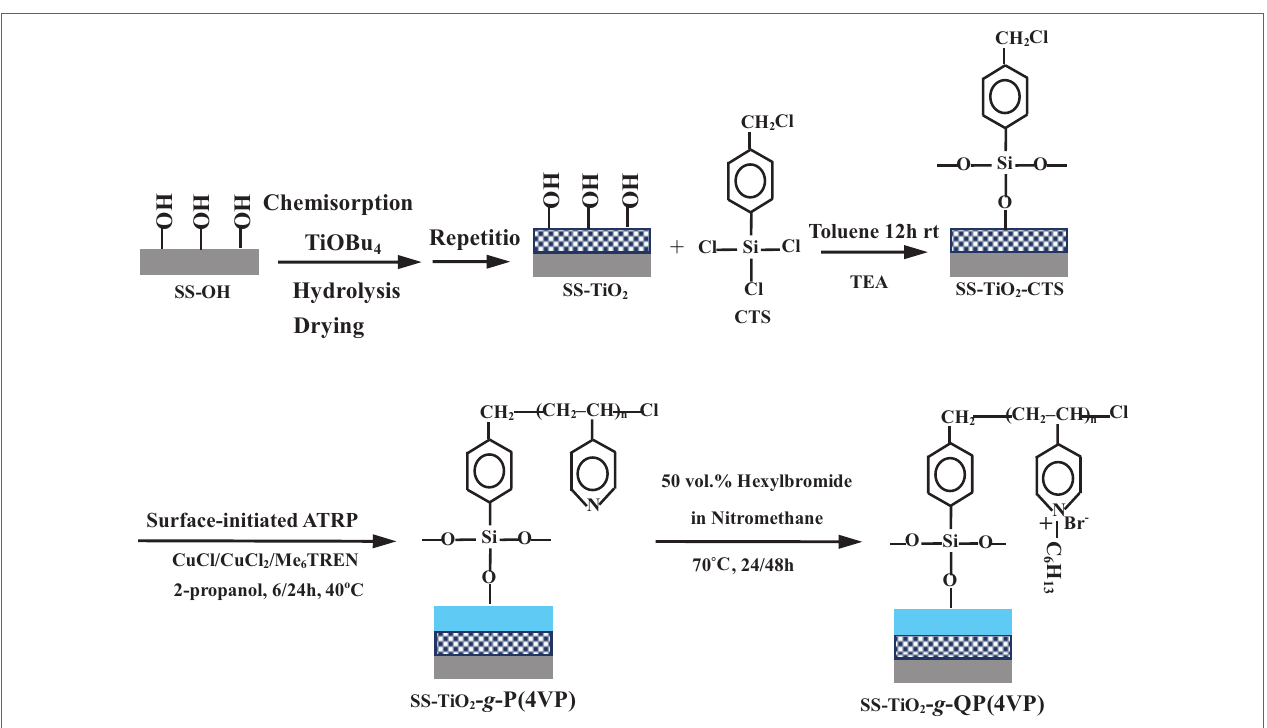
FiGURe 6 | Process in preparing organic/inorganichybrid coatings via combination of layer-by-layer sol-gel deposition and surface-initiated atom transfer radical polymerization of 4-vinyl pyridine. Reprinted with permission from Yuan et al. (2010a). Copyright 2009 American Chemical Society.